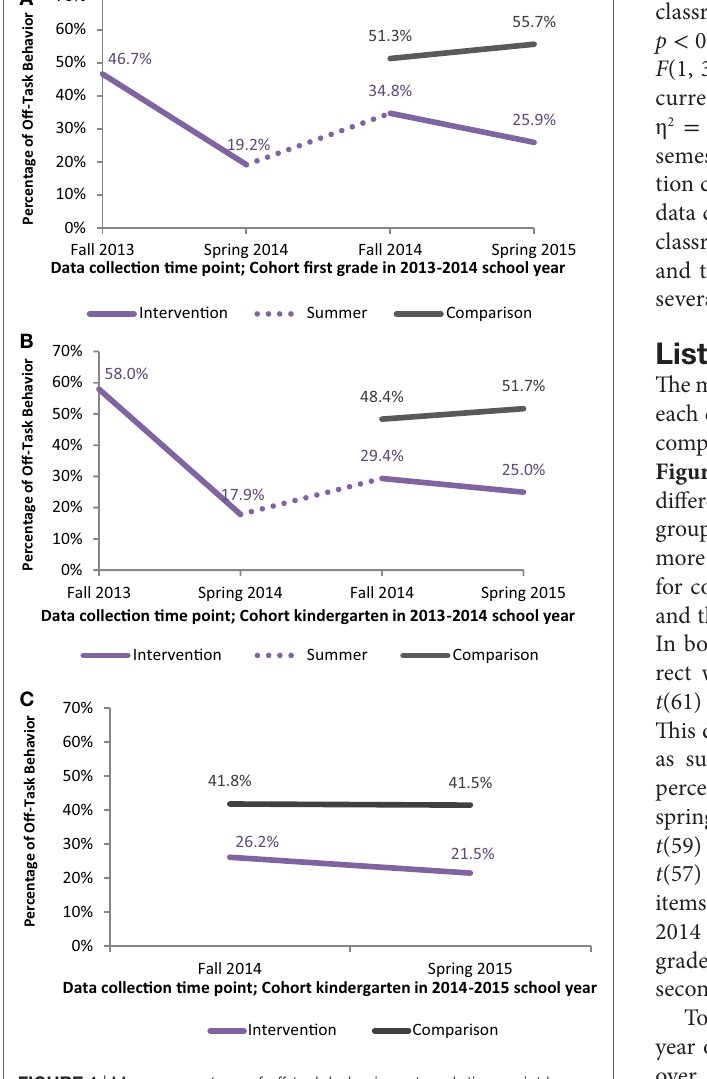
FigUre 1 | Mean percentage of off-task behaviors at each time point by group and cohort, (a) cohort first grade in 2013-2014 school year, (B)